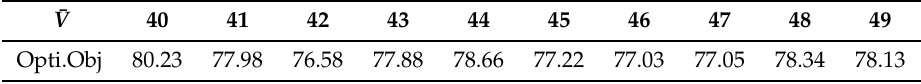
Table 5. The computational results with different ¯ V